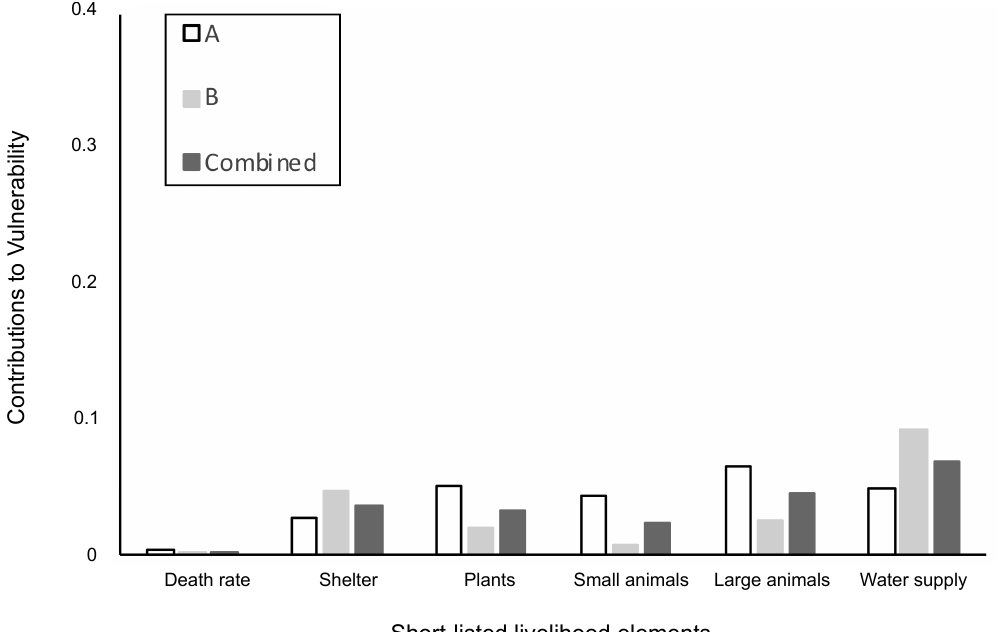
Figure 6: Participant A and B and combined contributions to vulnerability from the six short-listed fields for 5 cm tephra